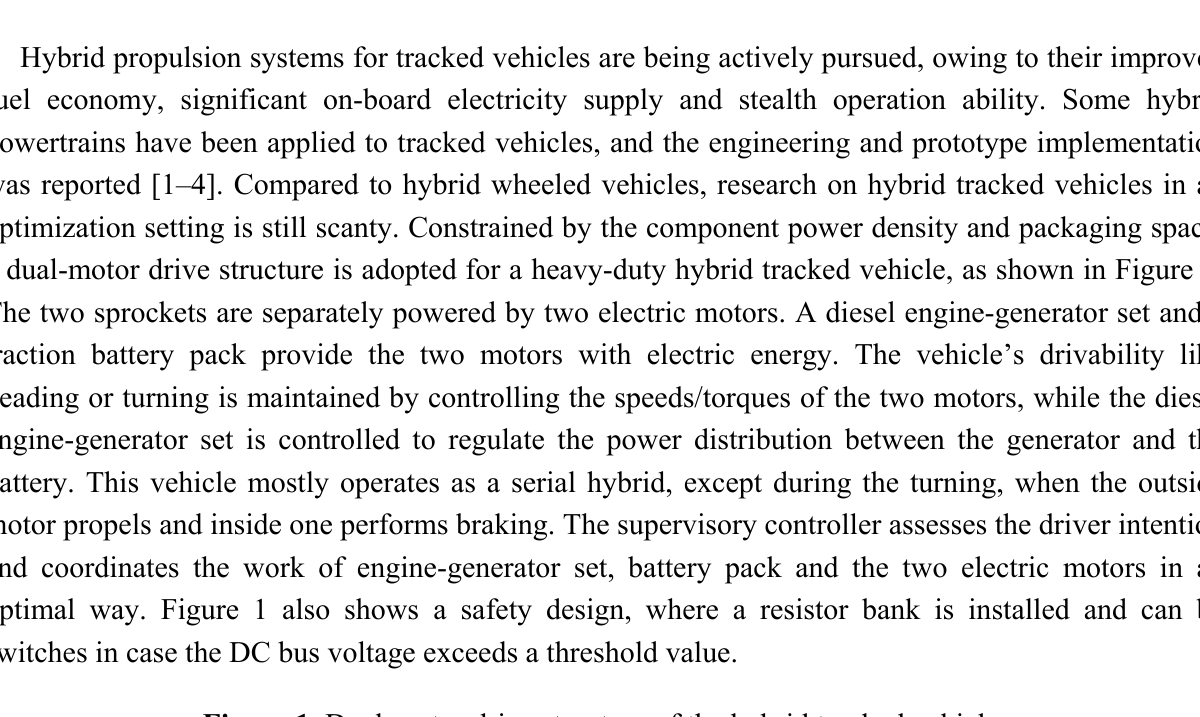
Figure 1. Dual-motor drive structure of the hybrid tracked